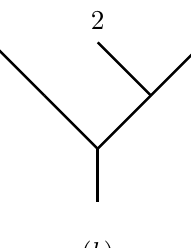
of the corresponding abc